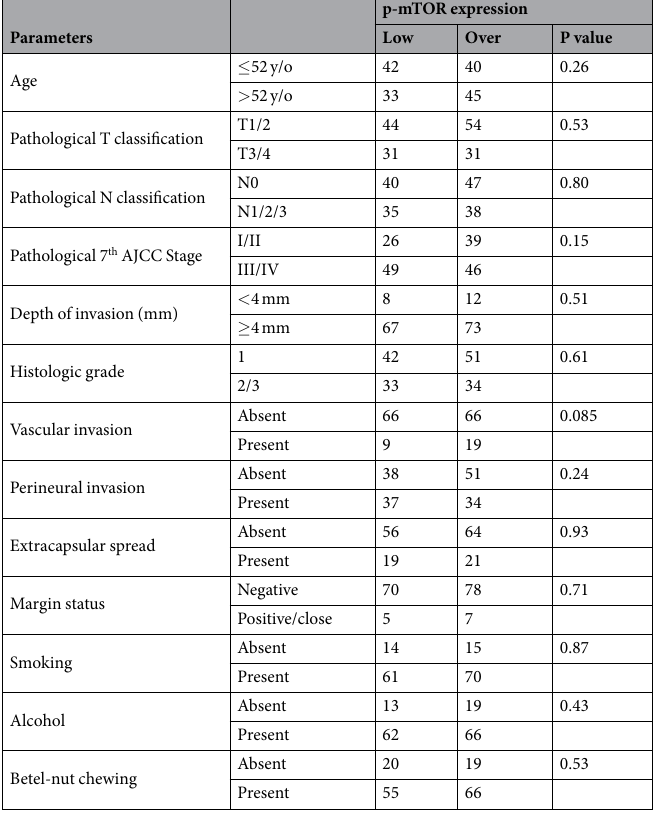
Table 2. Associations between p-mTOR expression and clinicopathologic parameters in 160 patients with tongue squamous cell carcinoma. Abbreviation: p-mTOR, phosphorylated mammalian target of rapamycin. * Statistically significant. х 2 test or Fisher’s exact test was used for statistically